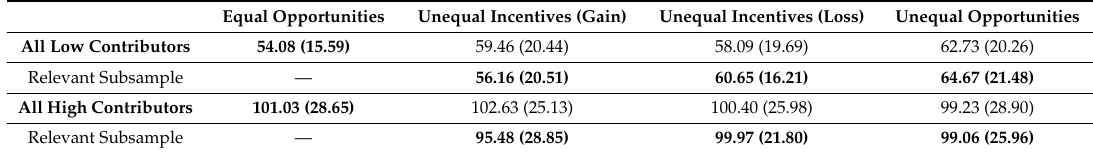
Table 4. Minimum demands in case of unequal